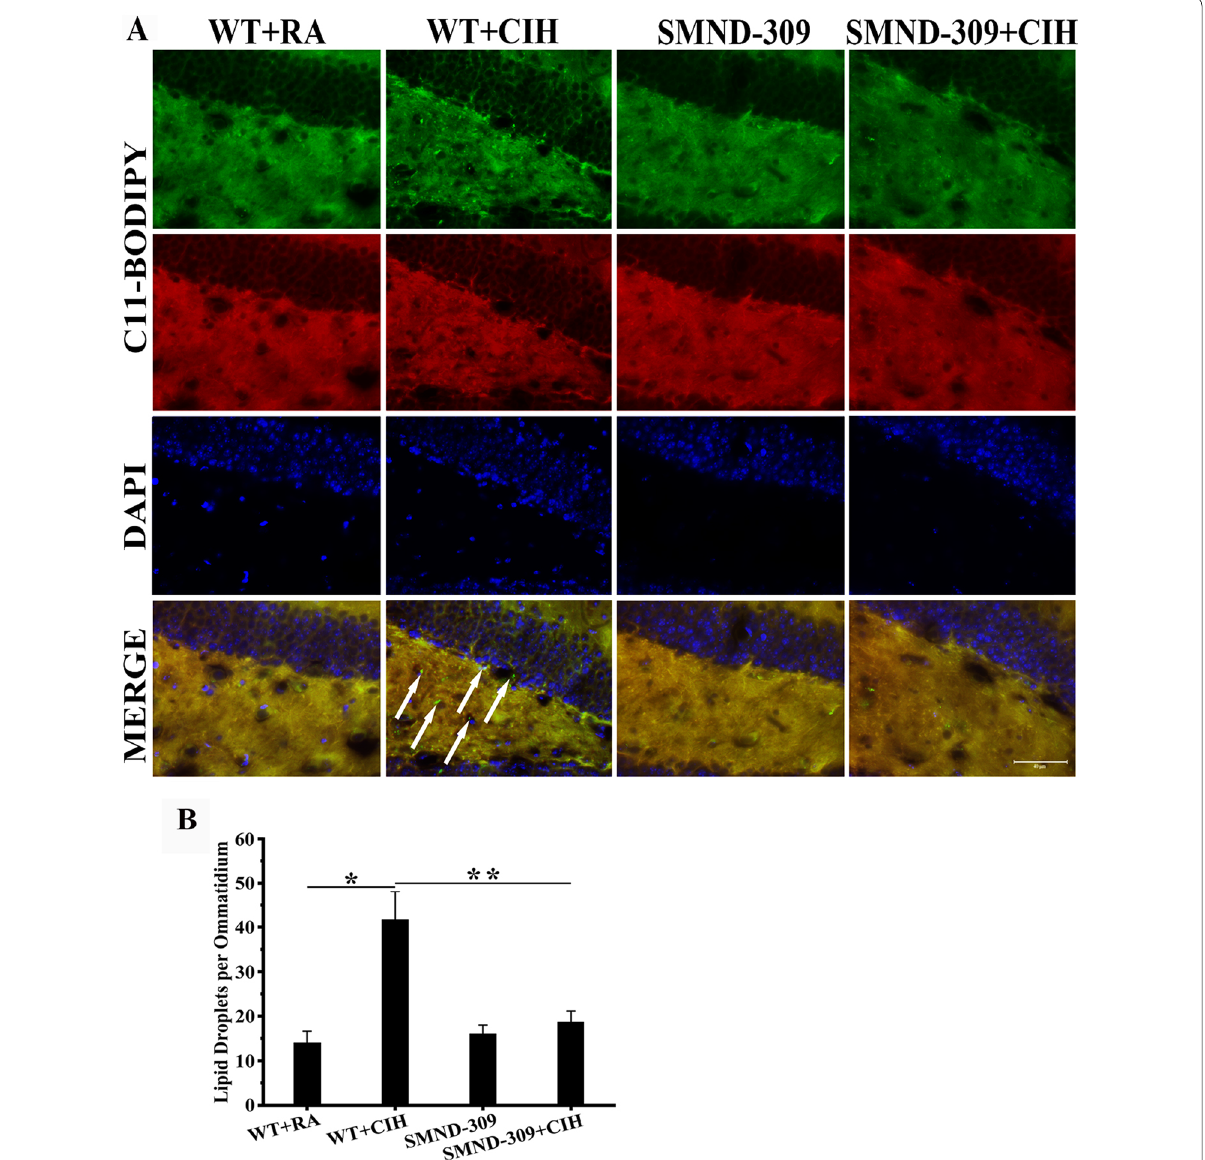
Fig. 10 Lipid peroxidation in nerve and glia cells. A C11-BODIPY (581/591) (red, green) and DAPI (blue) staining of the DG region. Lipid peroxidation could be observed (green, white arrow) in nerve and glia cells and SMND-309 inhibited peroxidation. B Quantification of peroxidized lipid in the nerve and glia cells. *p < 0.05 WT group vs. WT CIH group. **p < 0.05 WT CIH group vs. SMND-309 CIH group. All experiments were repeated three times. Data are shown as the mean SEM. Statistical analysis was performed with two-way ANOVA. Original magnification: 400 ±